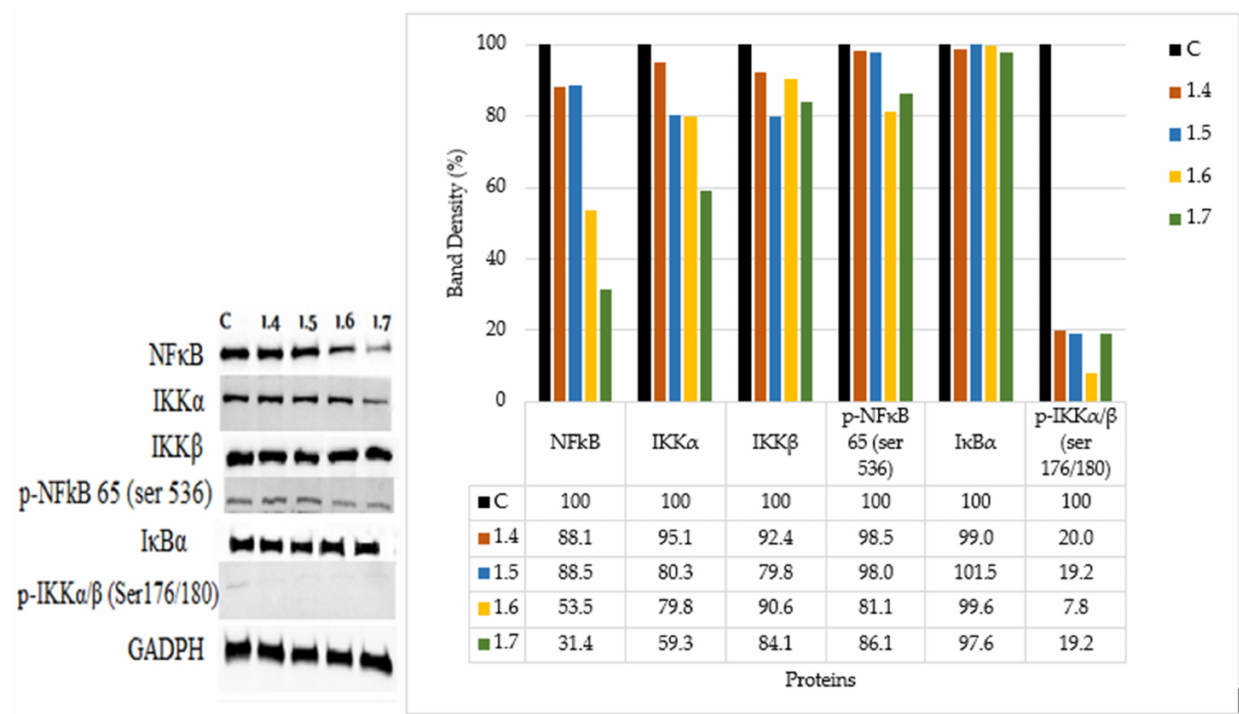
Figure 4. Western blot result of expressed protein signals by HeLa cells control group (with no treat- ment) and experimental groups treated with different concentrations (1.4, 1.5, 1.6, and 1.7 mg/mL) of GAMCE for 12 h. Band density of the blotted image was measured by using Adobe photoshop